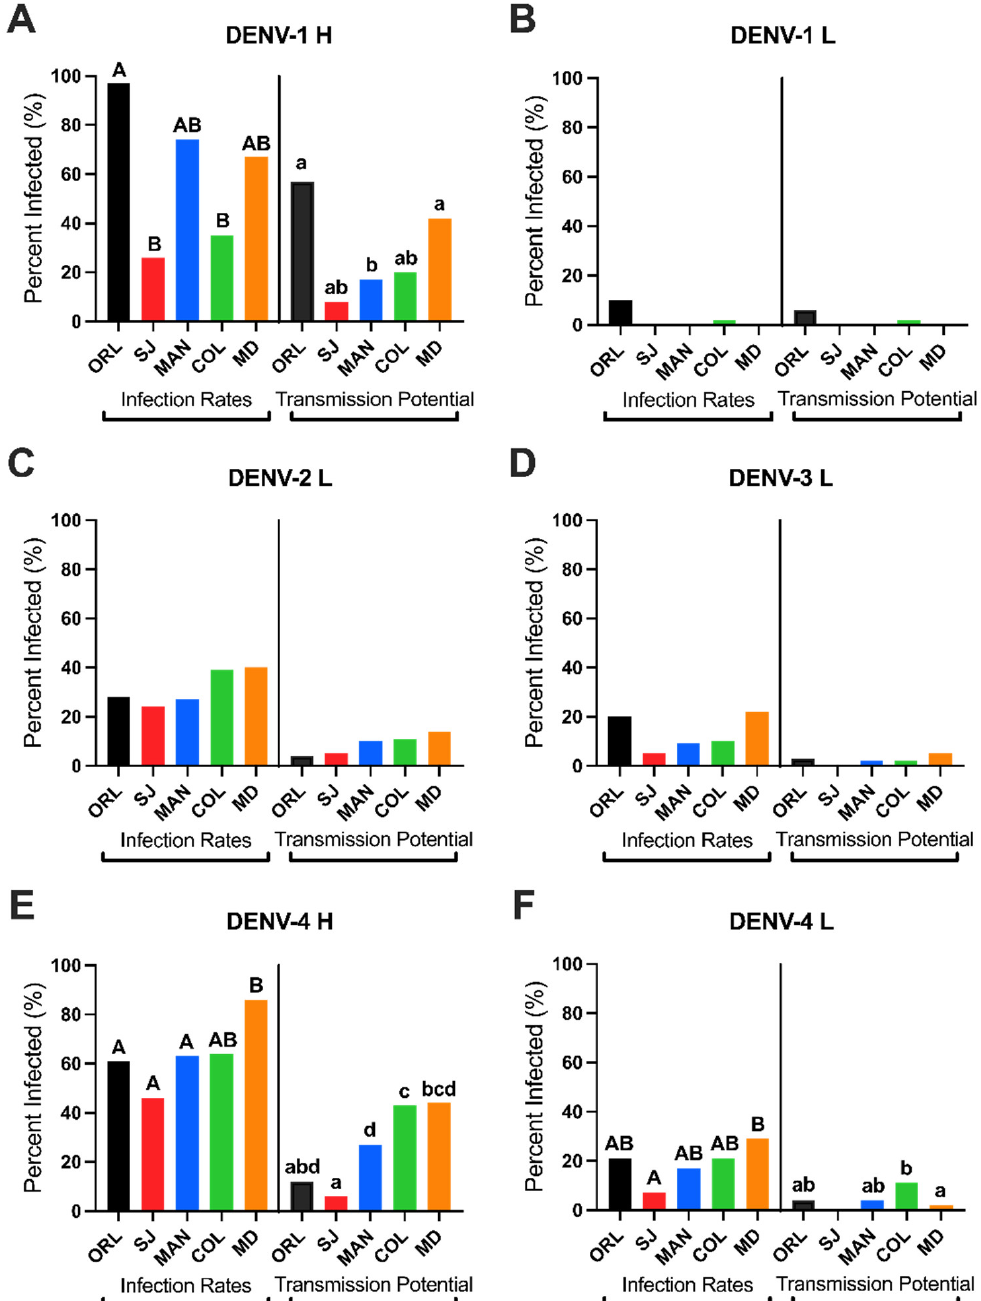
Figure 2. Infection rates and transmission potentials of Floridian Aedes aegypti mosquitoes (exposed to ( A ) DENV-1 Haiti, ( B ) DENV-1 laboratory, ( C ) DENV-2 laboratory, ( D ) DENV-3 laboratory, ( E ) DENV-4 Haiti, ( F ) DENV-4 laboratory) were highest for south FL (COL and MD) and laboratory (ORL) populations with low passage virus strains (DENV-1 H and DENV-4 H). Differences in alphabetical capital letters (A or B) denote statistical significance between infection rates within each virus group. Differences in lowercase letters (a, b, c, or d) denote statistical significance between transmission potentials within each virus group. Bars are averaged from three experimental replicates. Groups without any statistically significant differences do not have any alphabetical letter labeling. Significance is measured using an alpha level of 0.05 via multilevel logistic regression (infection rates) or binary logistic regression (transmission